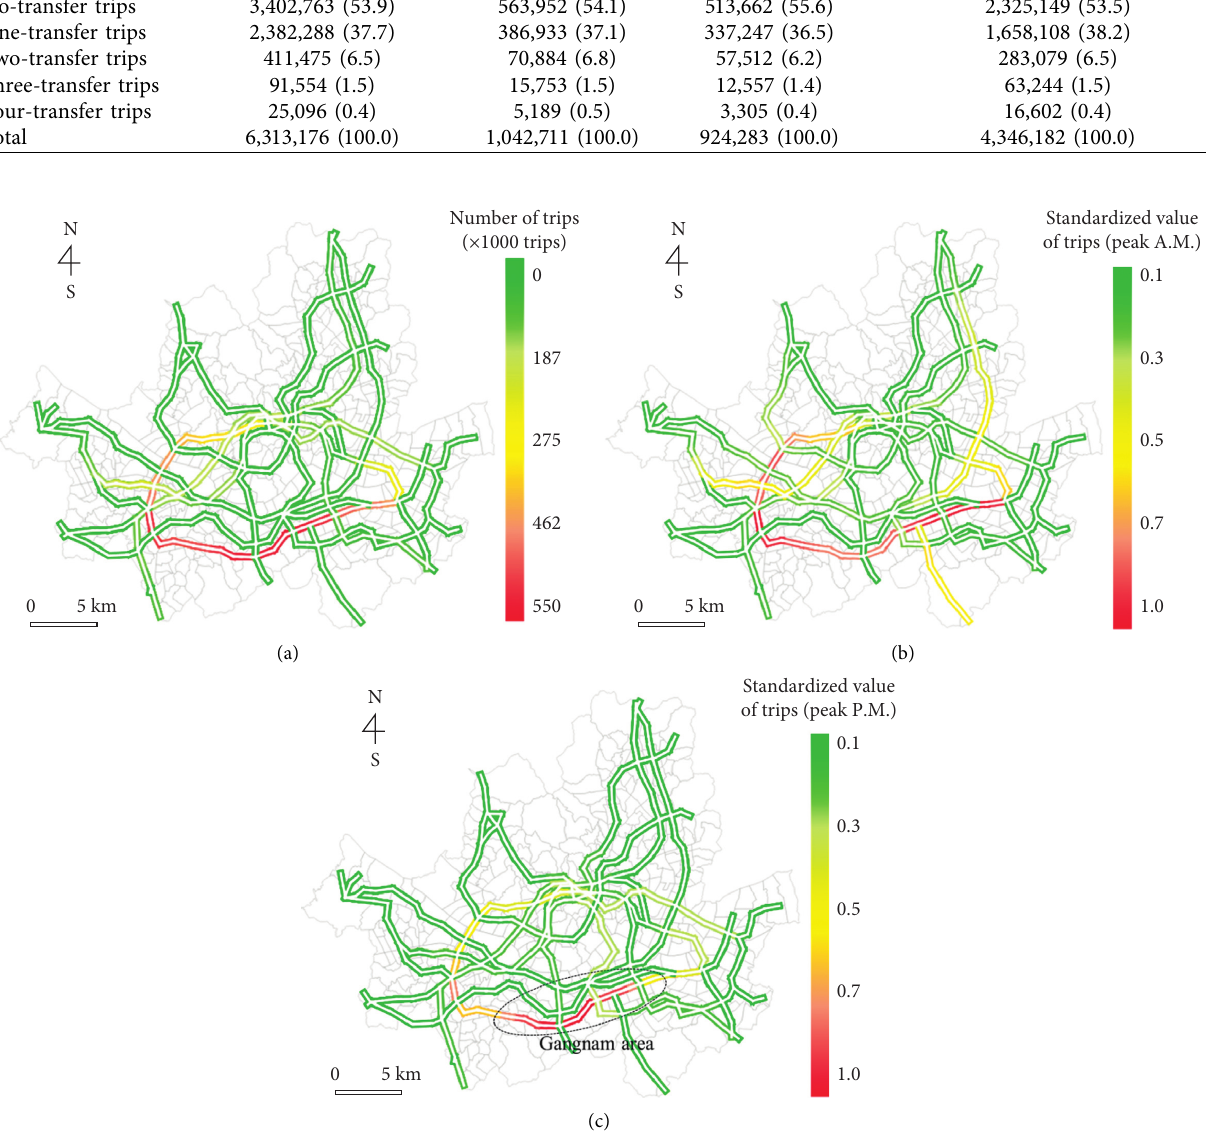
Figure 5: Visualization of estimated link trips of subway network in Seoul. (a) The number of link trips for a day. (b) Link trip density at peak A.M. (c) Link trip density at peak